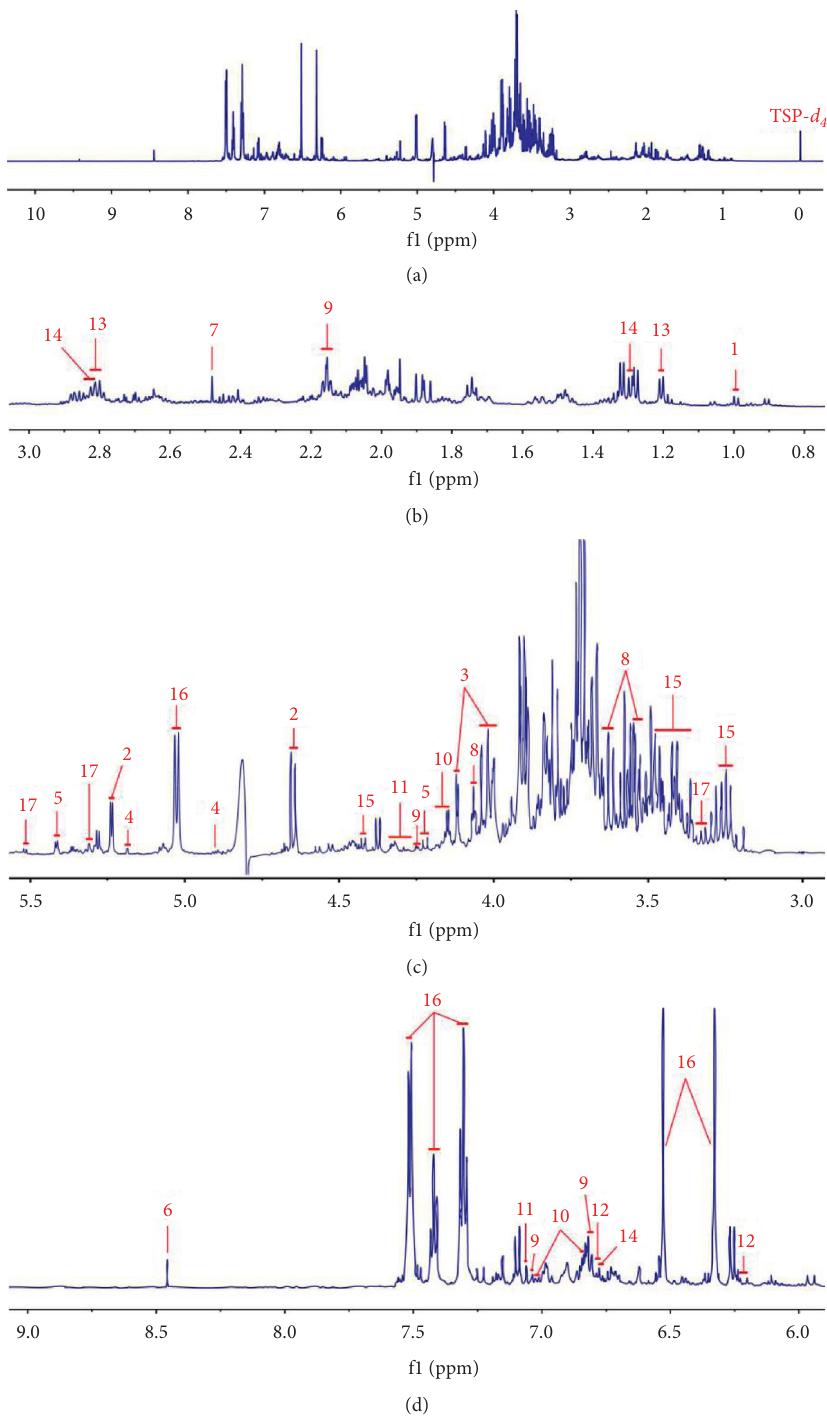
Figure 1: Representative 1 H-NMR spectrum of SHLI from δ 0.0 to 10.0 (a), enlarged spectrum between δ 0.8 and 3.0 (b), from δ 3.0 to 5.5 (c), and in the range of δ 6.0 and 9.0 (d). TSP- d 4 as an internal standard with a chemical shift at 0.0 ppm. Characteristic signal peaks of 17 metabolites: 1 valine; 2 glucose; 3 fructose; 4 mannose; 5 sucrose; 6 formic acid; 7 succinic acid; 8 myo -inositol; 9 chlorogenic acid; 10 neochlorogenic acid; 11 cryptochlorogenic acid; 12 caffeic acid; 13 forsythoside A; 14 isoforsythiaside A; 15 forsythoside E; 16 baicalin; 17